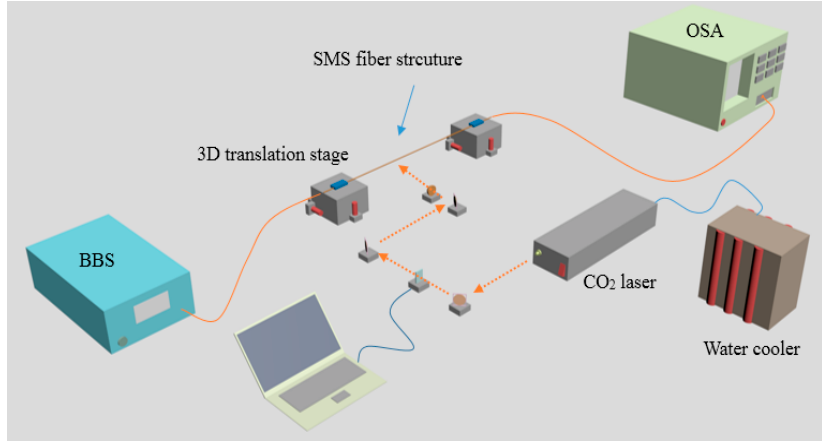
Figure 6. Experimental setup for fabricating an STMS fiber structure.